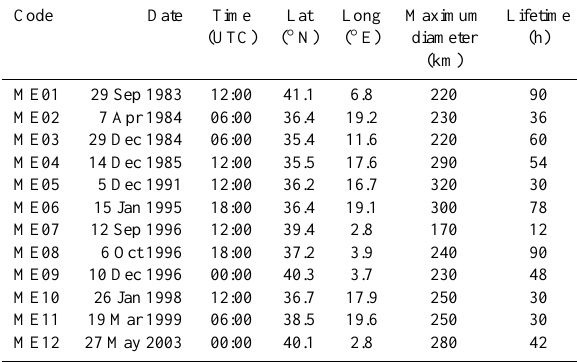
Table 1. Code, date, approximate time of mature phase and geo- graphical coordinates of medicane centers from 1983 to 2003 (Tous and Romero,